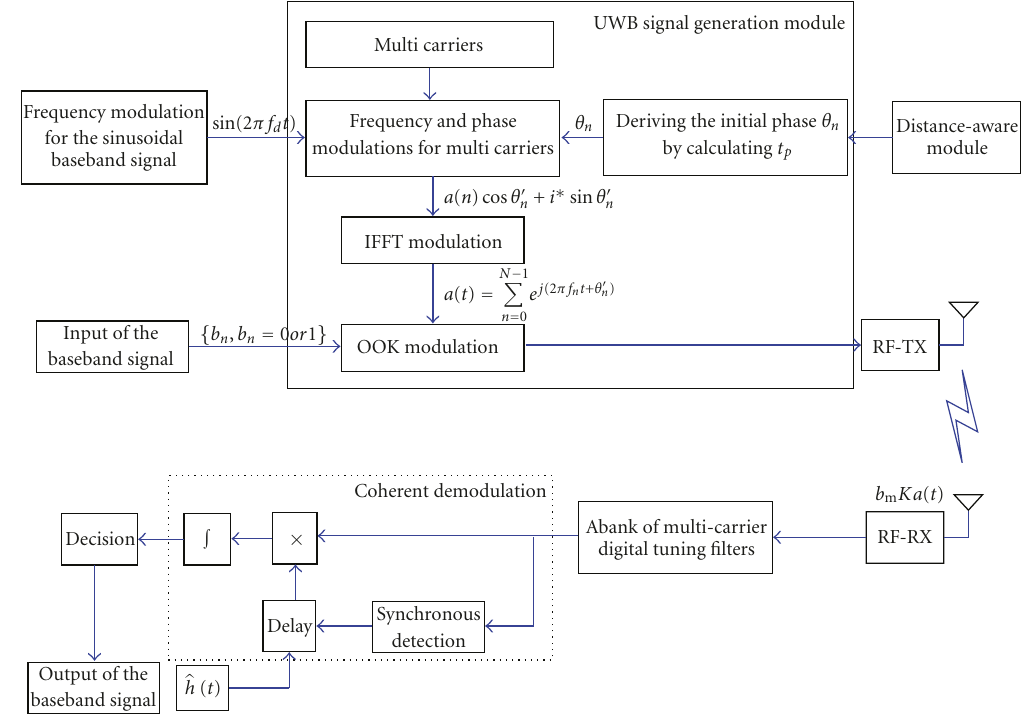
Figure 3: The diagram of the UWB signal modulation and